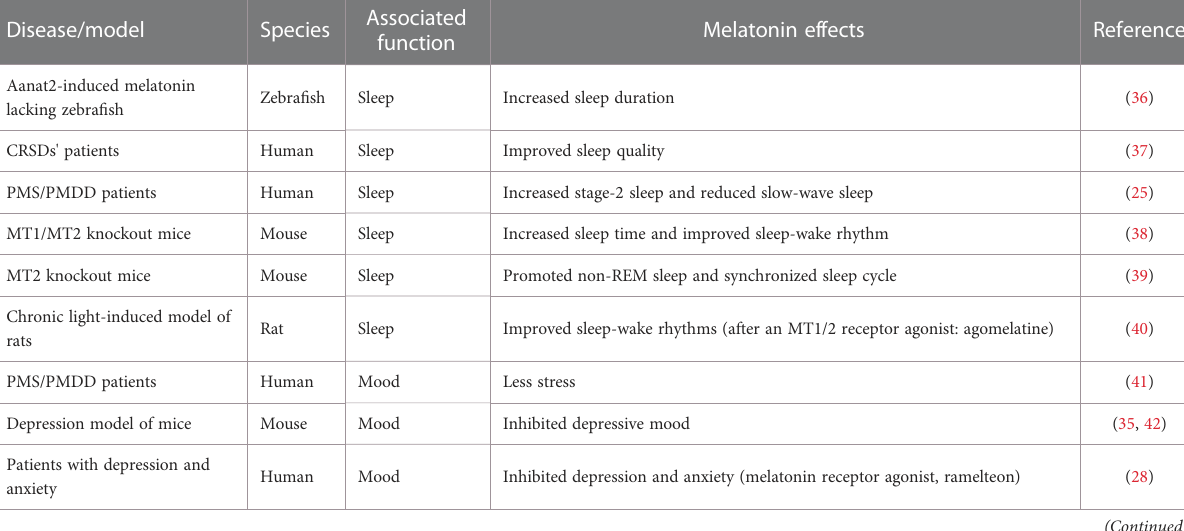
TABLE 2 Selected therapeutic effects of melatonin in PMS/PMDD-associated symptoms. Disease/model Species